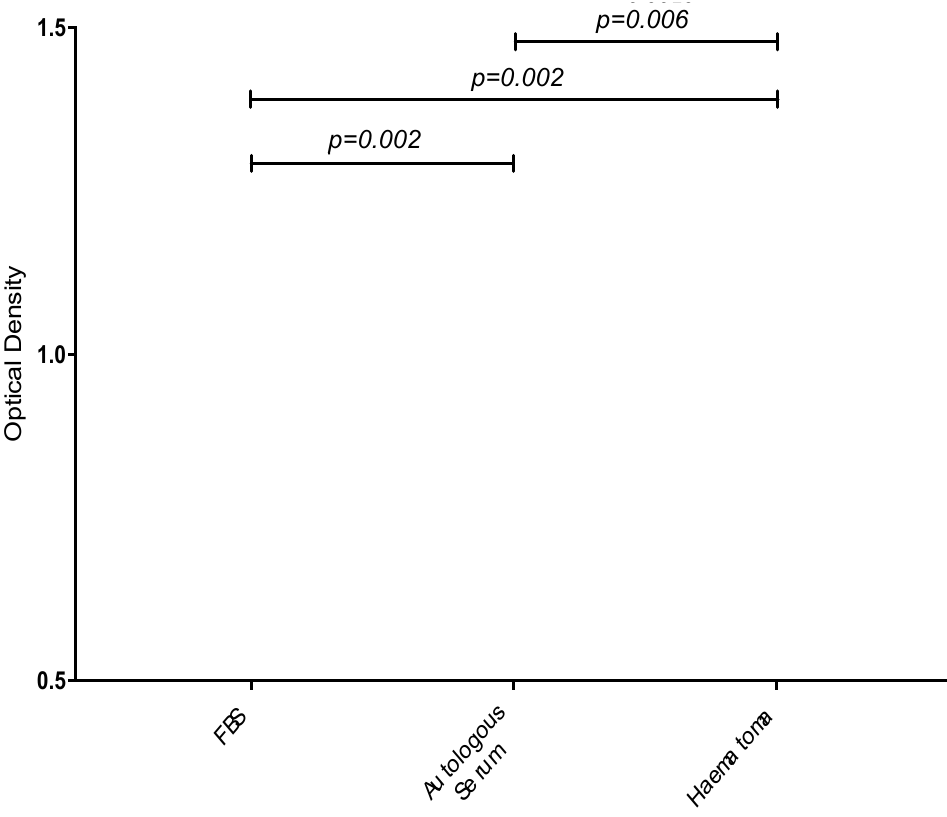
Table 3. Gene expression of autologous cells supplemented with fracture haematoma and peripheral serum. Gene Fold Difference in Expression